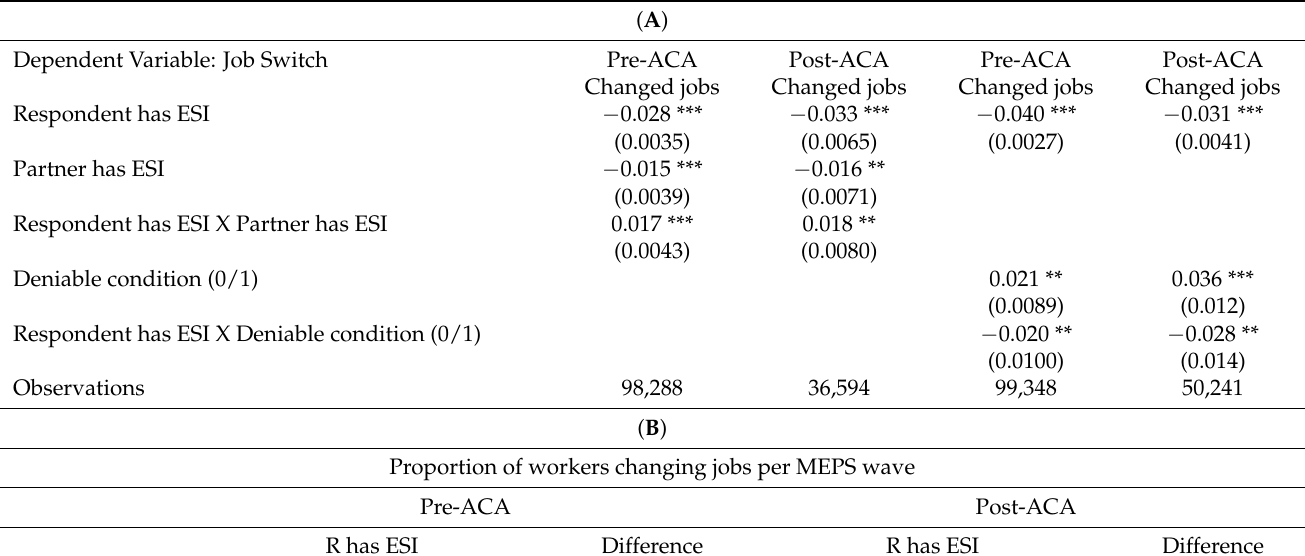
Table 3. ( A ) Difference-in-Differences Estimates of Partner ESI on Job Mobility. MEPS Analyses. ( B ) DD using Partner’s Insurance as Cost Factor. ( C ) DD using Respondent’s Deniable Health Condition as Cost